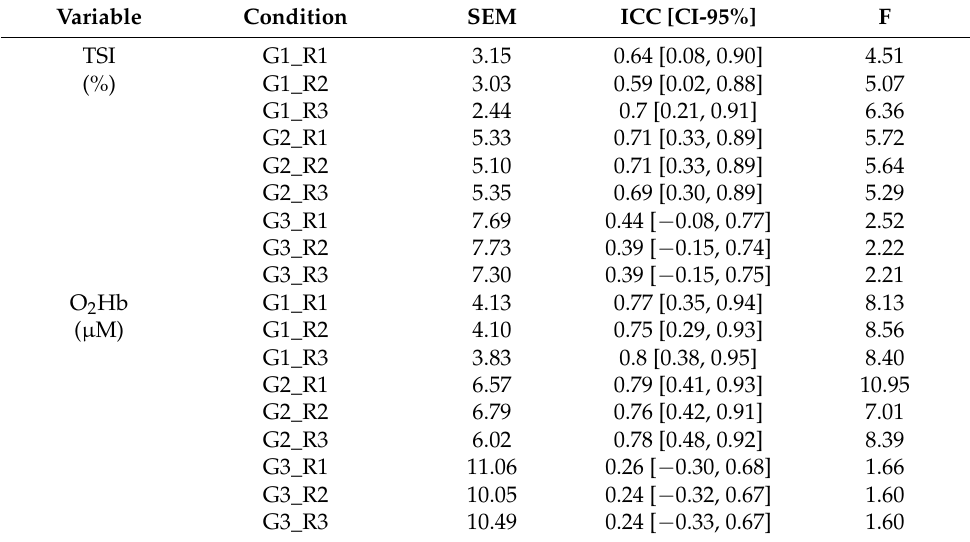
Table 10. Between-session reliability of minimums.